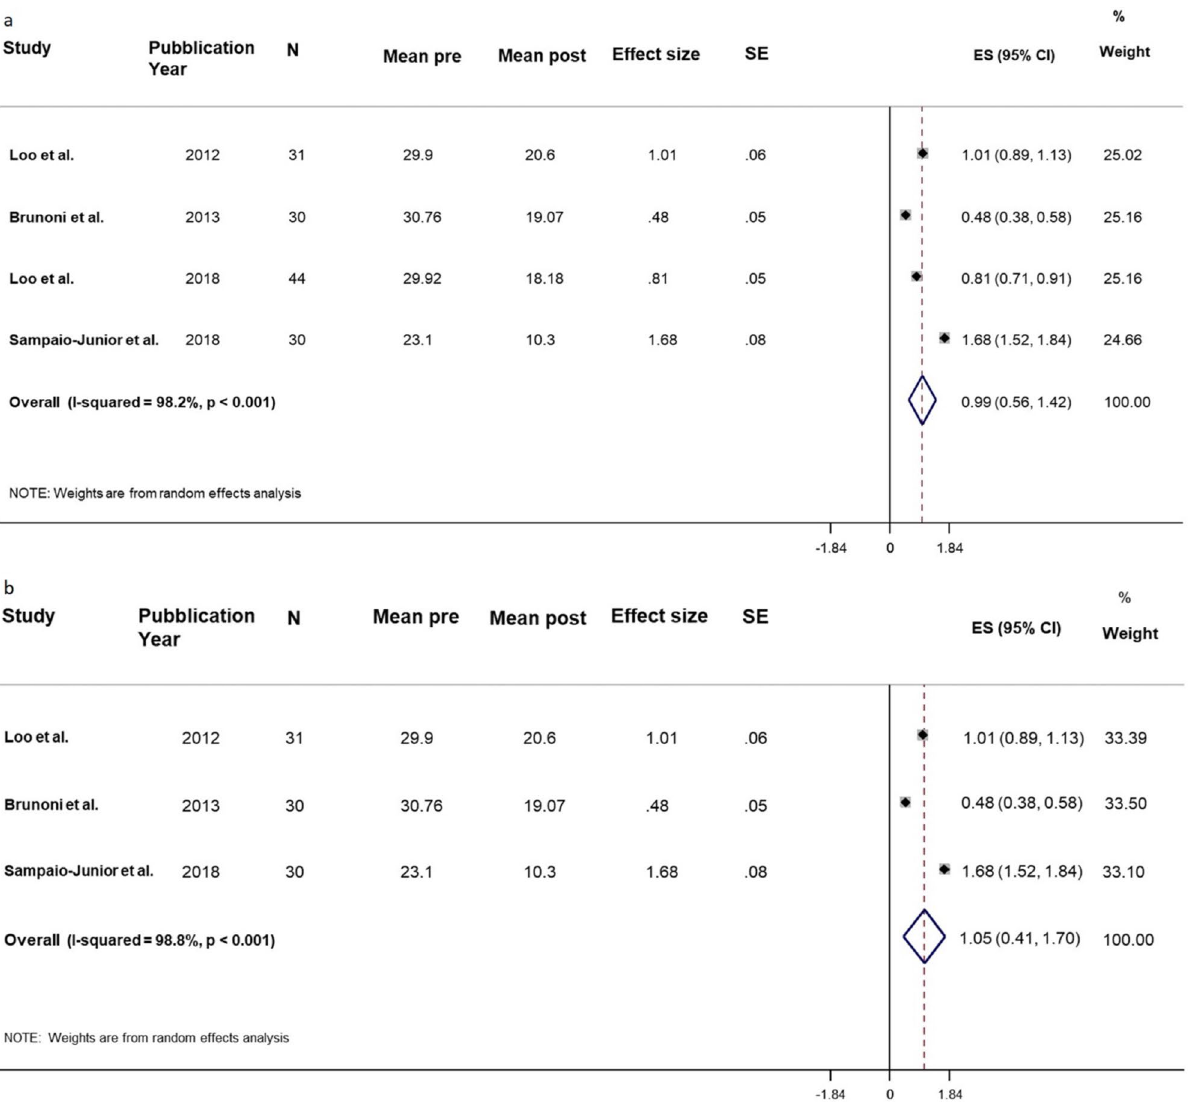
Figure 4. Depression. Real. ( a ) Forest plot of meta-analysis results considering all studies. The diamond represents the pooled standardized mean difference (SMD, dashed red vertical line) and its 95% confidence interval; vertical solid dark line is the line of equivalence. The estimates for each study and their 95% confidence intervals are represented by a box with whiskers, the dimension of grey box is proportional to the precision of the study. ( b ) Forest plot of sensitivity meta-analysis. Note: SE = Standard Error; ES = Effect Size. CI = Confidence Interval.